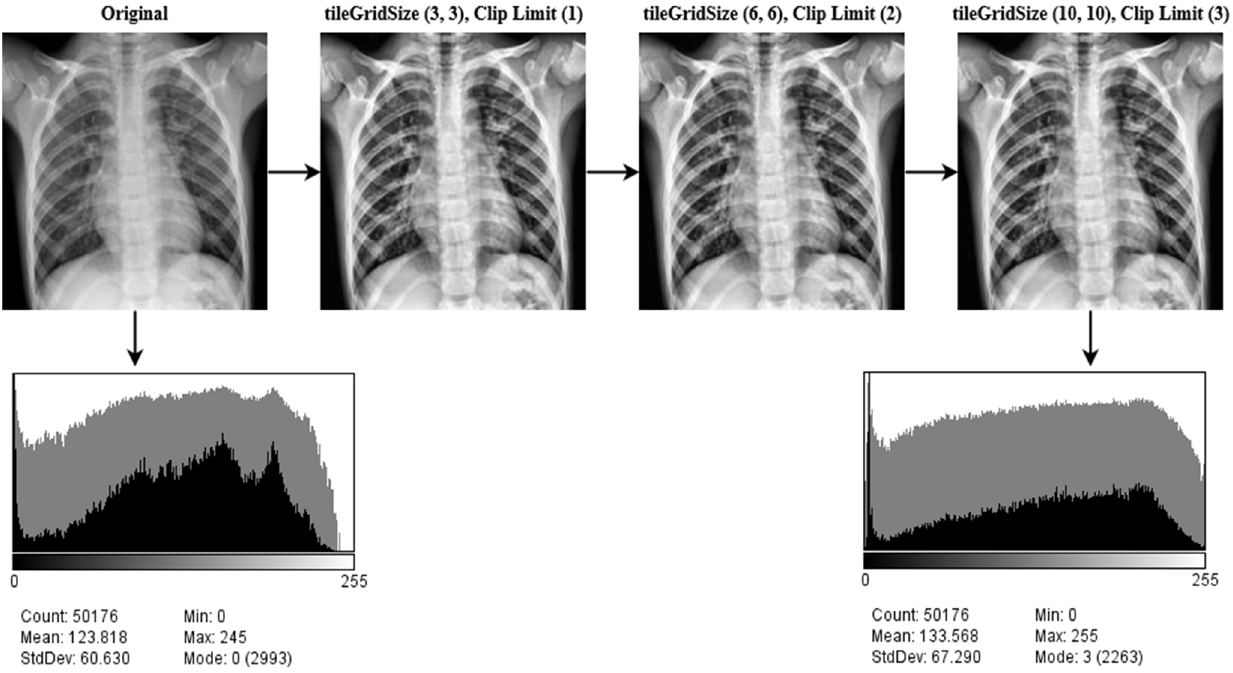
Figure 5. The result of CLAHE enhancement method implemented on ten classes: Control, COVID-19, Effusion, Lung Opacity, Mass, Nodule, Pulmonary Fibrosis, Pneumonia, Pneumothorax, and Tuberculosis, applying several tileGridSize (10, 10) and clip limit (3) permutations.